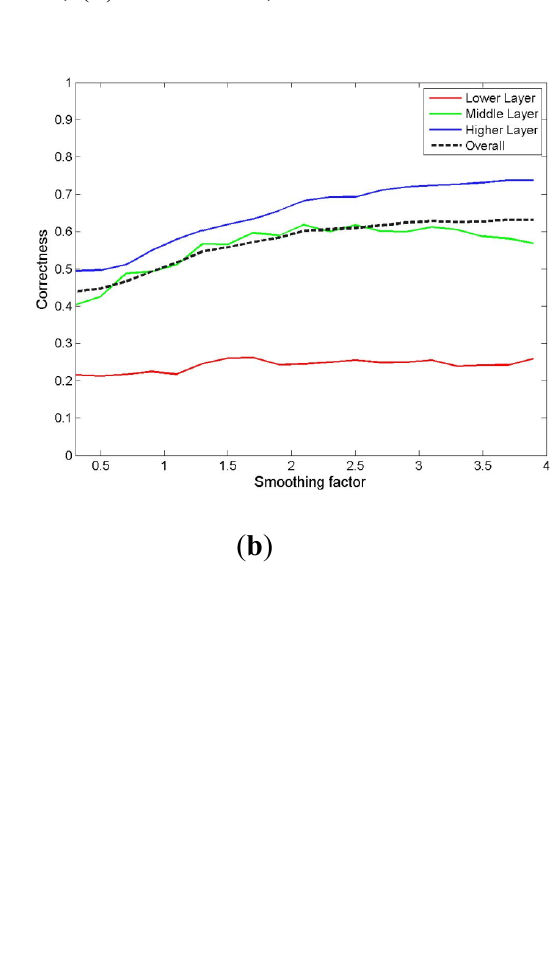
V for the dataset of Test Site I Size